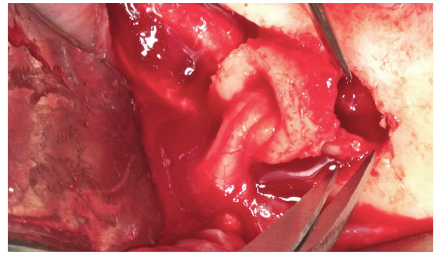
Figure 2: Computed tomography (cone beam) of the jaw, right side.